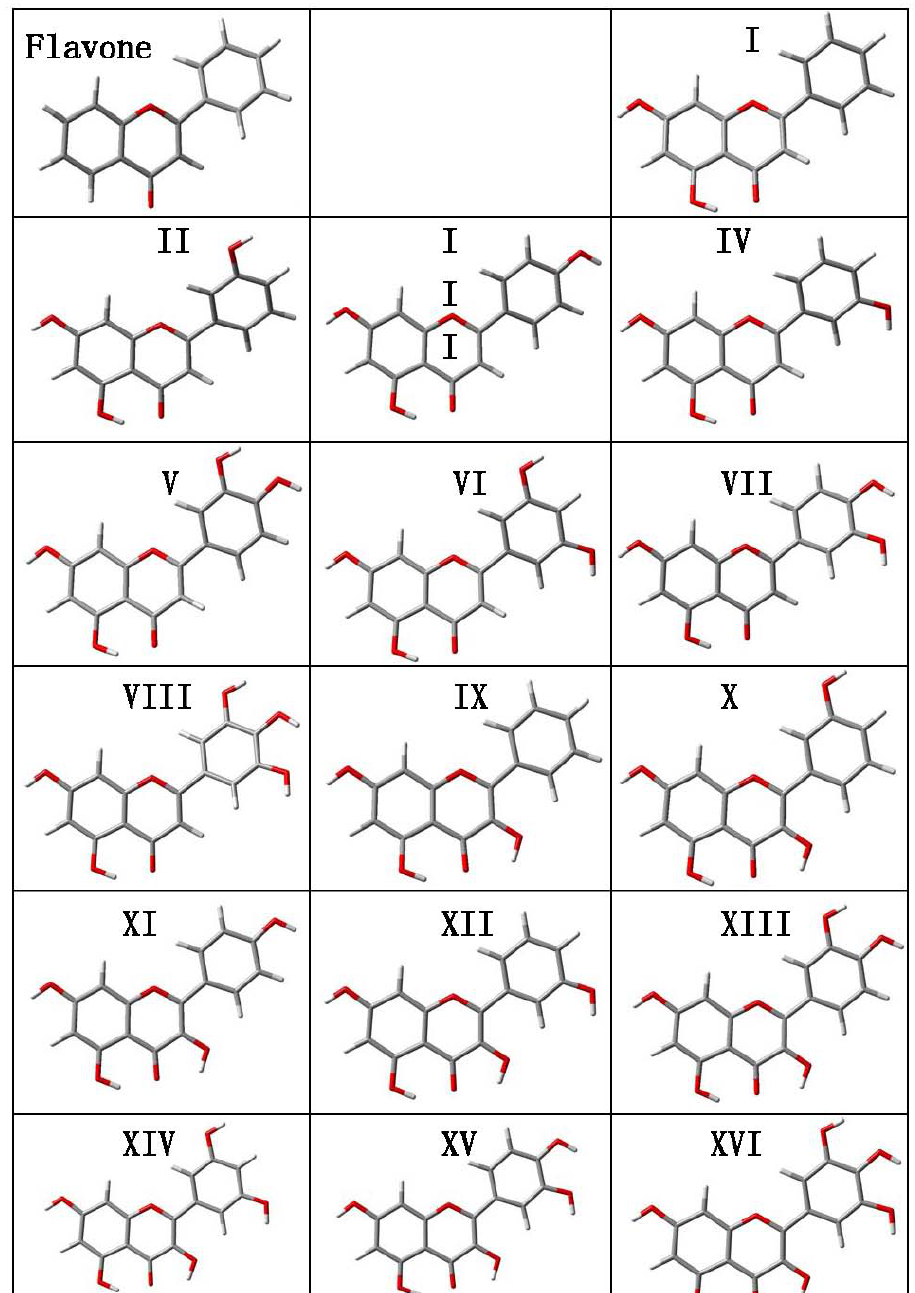
Figure 2. Optimized structures the of studied flavonoids calculated in gas phase at the B3LYP ⁄⁄ 6-311++G** theoretical level. Atom color code: oxygen (red), carbon (gray) and hydrogen